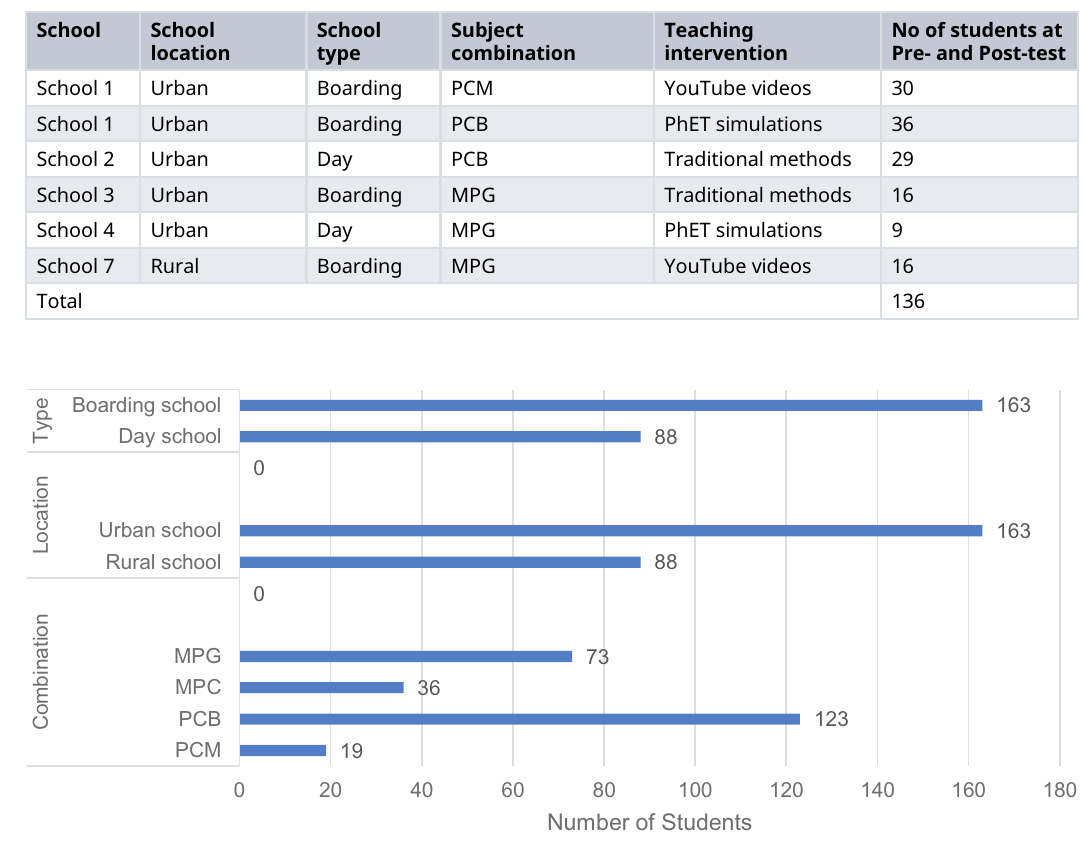
Table 2. Characteristics of data from the Geometric Optics Conceptual Understanding Test (GOCUT) implemented at S4 or Grade 10. Note: PCM: Physics-Chemistry-Mathematics, PCB: Physics-Chemistry-Biology,